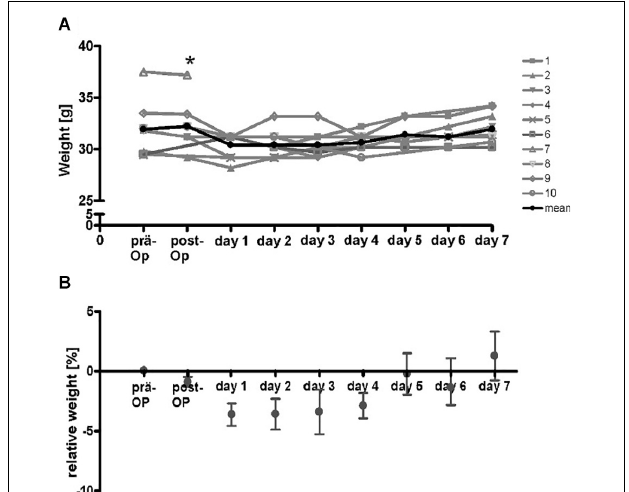
FIGURE 4 | Course of weight of wt-mice ( n = 10) at the time-points before operation, directly after operation and on the following 7 days. The additional gain of weight of the implanted stimulator was subtracted from values after implantation (A) absolute weight-course. * Drop-out. Gray lines, respective mice, black line mean of absolute weight. (B) Calculated means of relative weight. Initial weight was reached after 5